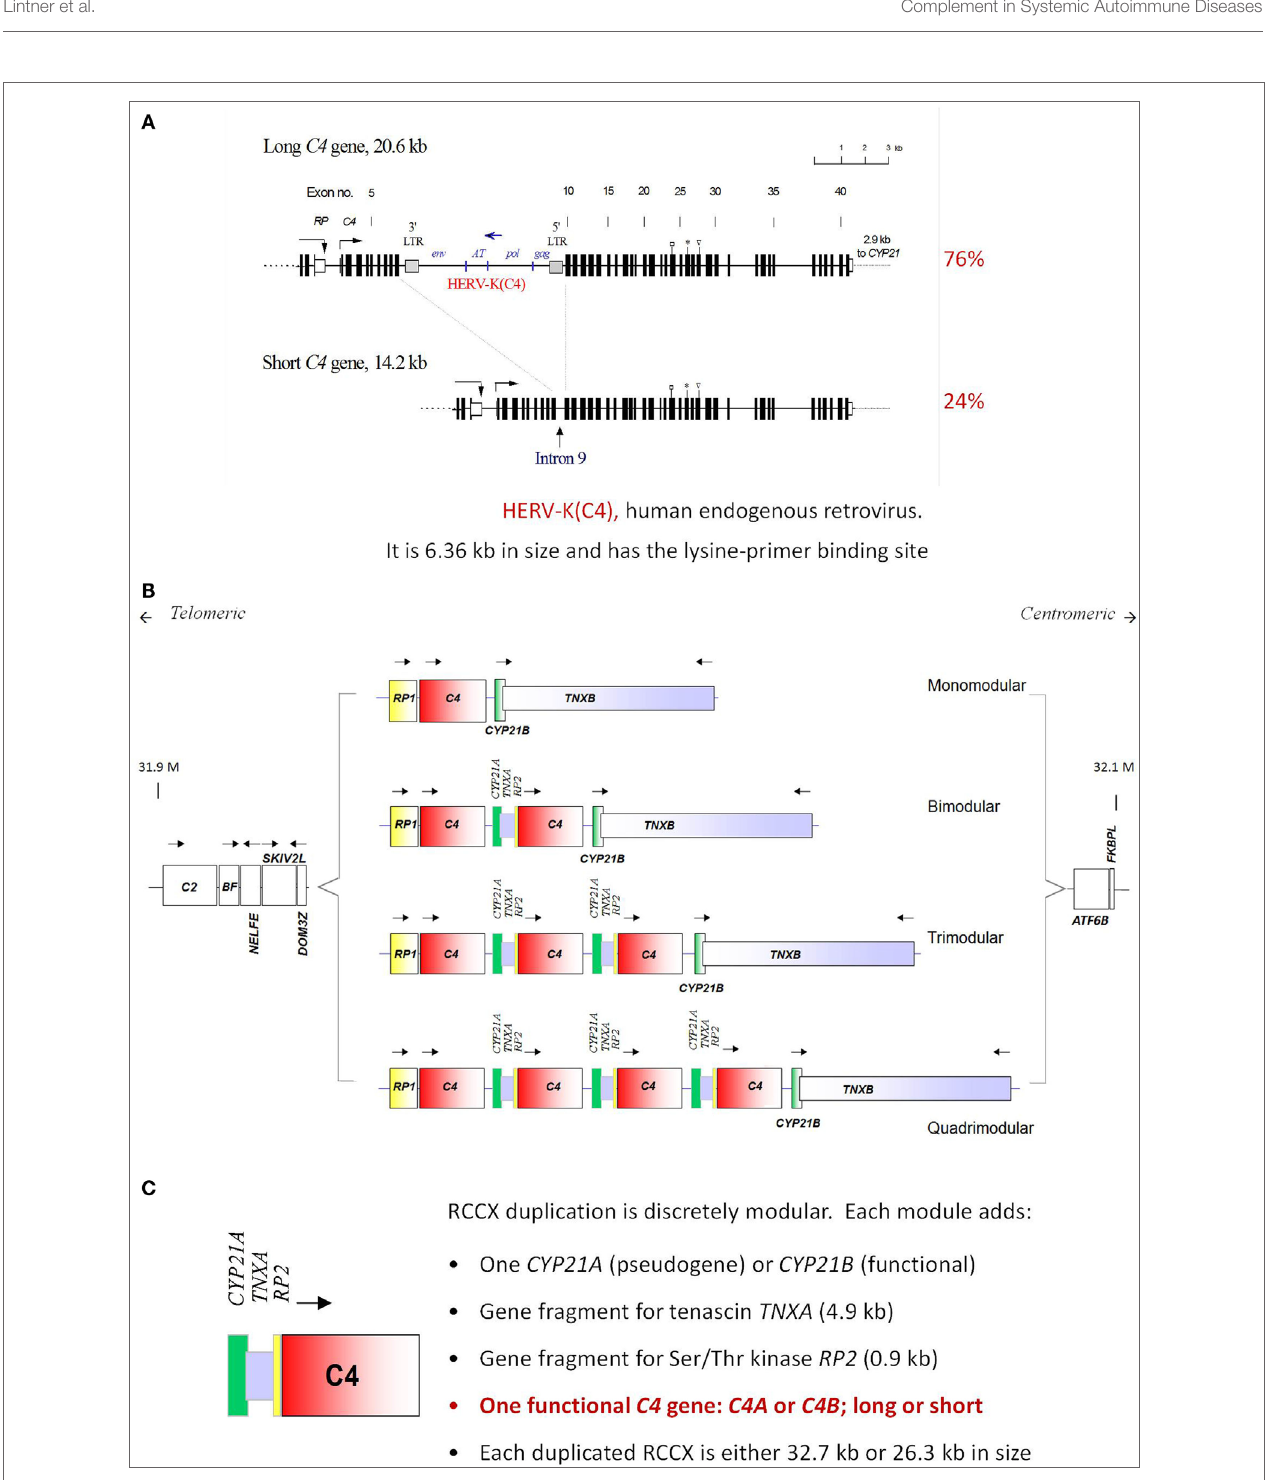
FiGURe 4 | Gene size dichotomy and gene copy-number variation of complement C4 . A human C4 gene consists of 41 exons coding for a precursor protein of 1744 amino acids including a signal peptide of 19 amino acids. (A) There are two forms of C4 genes. The long gene is 20.6 kb, and the short gene is 14.2 kb. In a long C4 gene, an endogenous retrovirus HERV-K (C4), which is 6.4 kb in size, integrated into its ninth intron. Among healthy subjects of European ancestry, 76% of C4 genes belong to the long form and 24% belong to the short form. (B) Among European subjects, one to four copies of C4 genes are present in the central region of the major histocompatibility complex (MHC) located on chromosome 6p21.3. Thus, there is a continuous variation in copy number of C4 genes from two to eight copies among different human subjects. (C) The duplication of a C4 gene occurs in a modular fashion, with a 0.9 kb fragment of RP (STK19) upstream of complement C4, a full steroid cytochrome P450 21-hydroxylase (CYP21) and a 4.0 kb fragment of the tenascin (TNX) at the downstream region of C4 (known as a RCCX module). The duplication of CYP21 gene can be a pseudogene (CYP21A or CYP21A1P) or an intact functional gene (CYP21B or CYP21A2). Each C4 gene in the RCCX module may either code for an acidic C4A or a basic C4B. Each C4 gene may be either long or short [adopted from Ref.